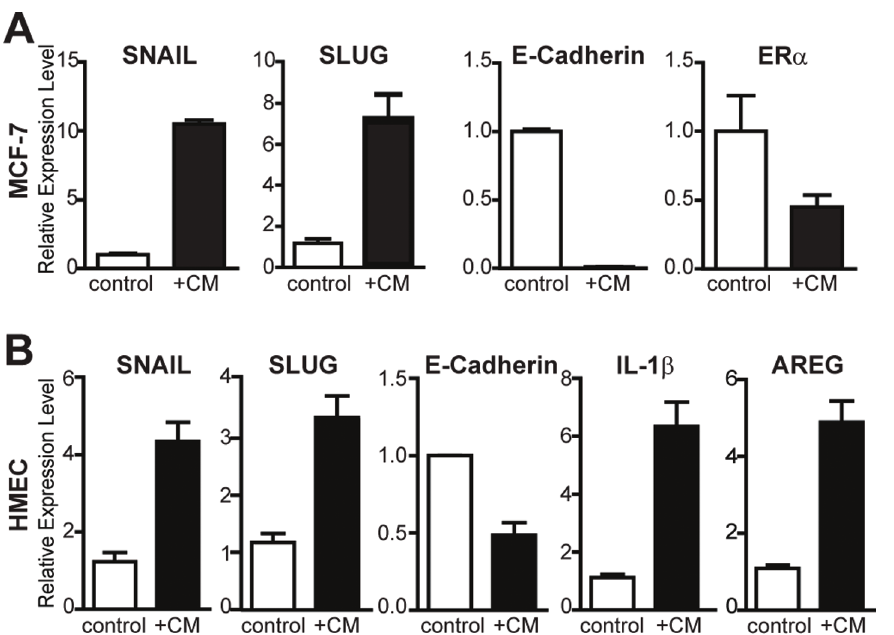
Figure 4. Treatment of cancerous and normal breast cells with conditioned medium (CM) alters gene expression. (A) Gene expression changes in MCF-7 cells treated with CM reveal a 10-fold increase in SNAIL, a 7-fold increase in SLUG, and elimination of detectable E-Cadherin mRNA. The increase in EMT markers is accompanied by a down-regulation of ER a mRNA. (B) After treatment of HMEC grown in monolayer culture with CM, there were changes in expression of EMT markers and increases in IL-1 b and the growth factor amphiregulin (AREG), suggesting an important role for paracrine signaling between the tumor microenvironment and adjacent normal epithelium.